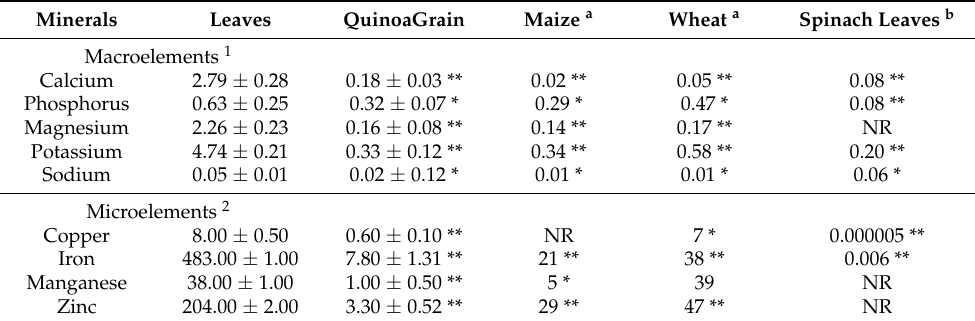
Table 3. Comparison of macro and microminerals in quinoa leaves with quinoa grains and other plants (dry weight of the sample).